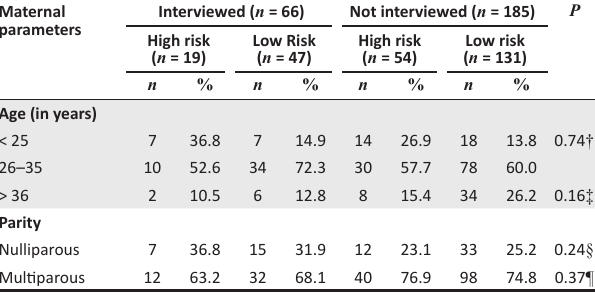
TABLE 4: Interviewed versus non-interviewed women. Maternal Interviewed ( n = 66) Not interviewed ( n = parameters